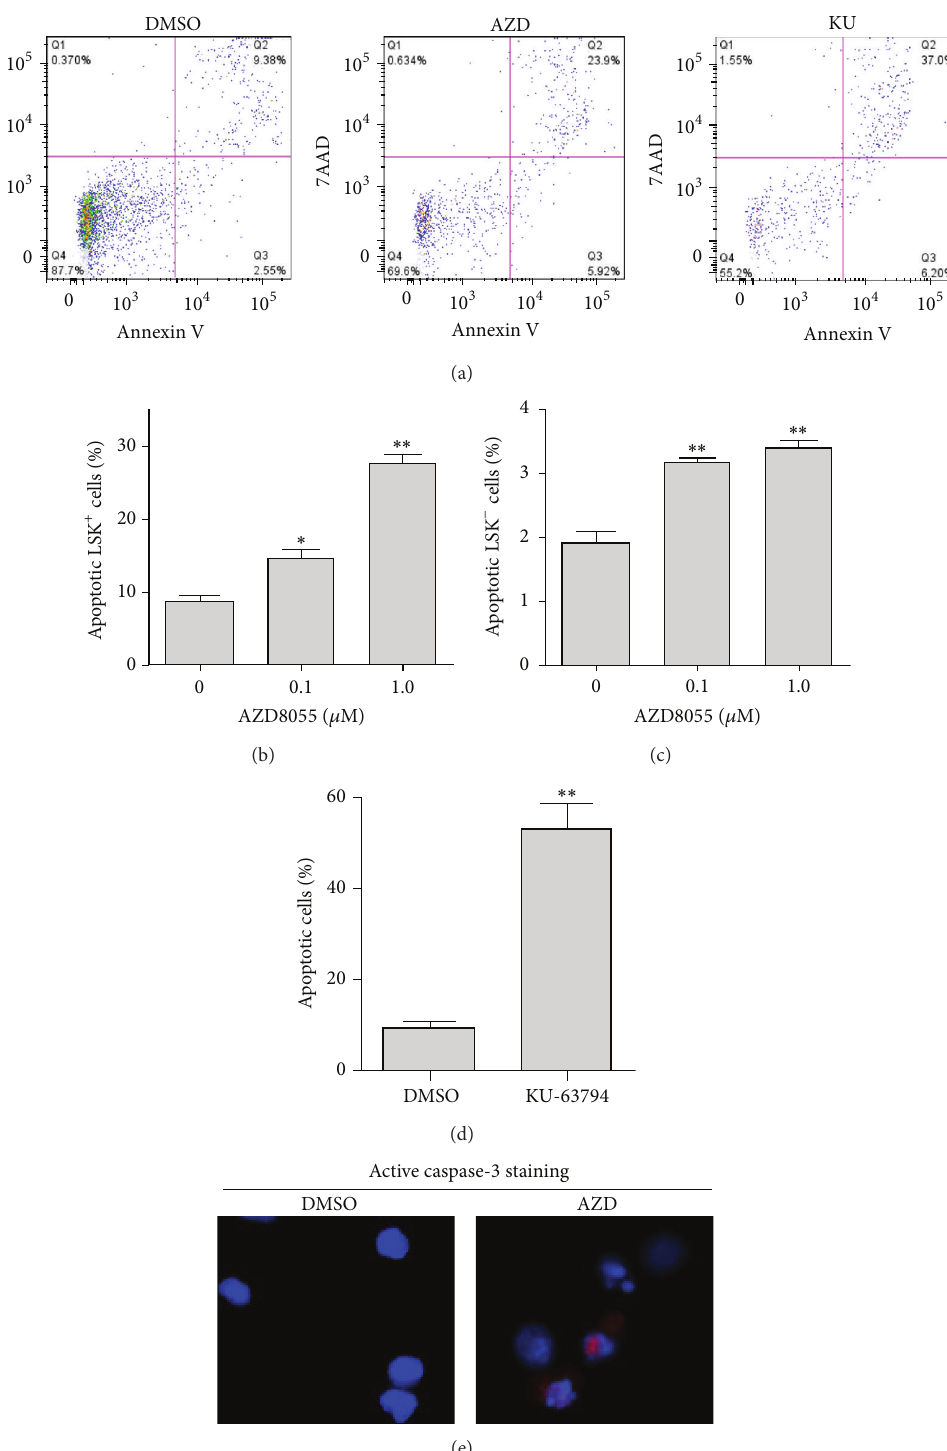
Figure 2: Inhibition of mTOR induces apoptosis in HSPCs. (a) Representative flow cytometric graphs of apoptosis assays using an apoptosis analysis kit as we previously reported [13]. (b) The percentage of apoptotic cells in LSK + subpopulations after different doses of AZD treatment is presented. (c) The percentage of apoptotic cells in LSK − subpopulations after different doses of AZD treatment is presented. (d) The percentage of apoptotic LSK + cells in cultured mouse BMLin − cells after KU-63794 (10 𝜇 M) treatment is presented. (e) Mouse lineage negative HSPCs were treated with AZD (0.1 𝜇 M) or DMSO as vehicle control for 16h. Active caspase-3 immunostaining was performed to determine apoptotic cells in HSPCs. Representative photomicrographs of active caspase-3 immunofluorescent staining (red) and nucleic counterstaining with DAPI (blue) are shown. Data are presented as mean +/ − SEM of three independent experiments. ∗ 𝑝 < 0.05 ; ∗∗ 𝑝 < 0.01 versus DMSO vehicle